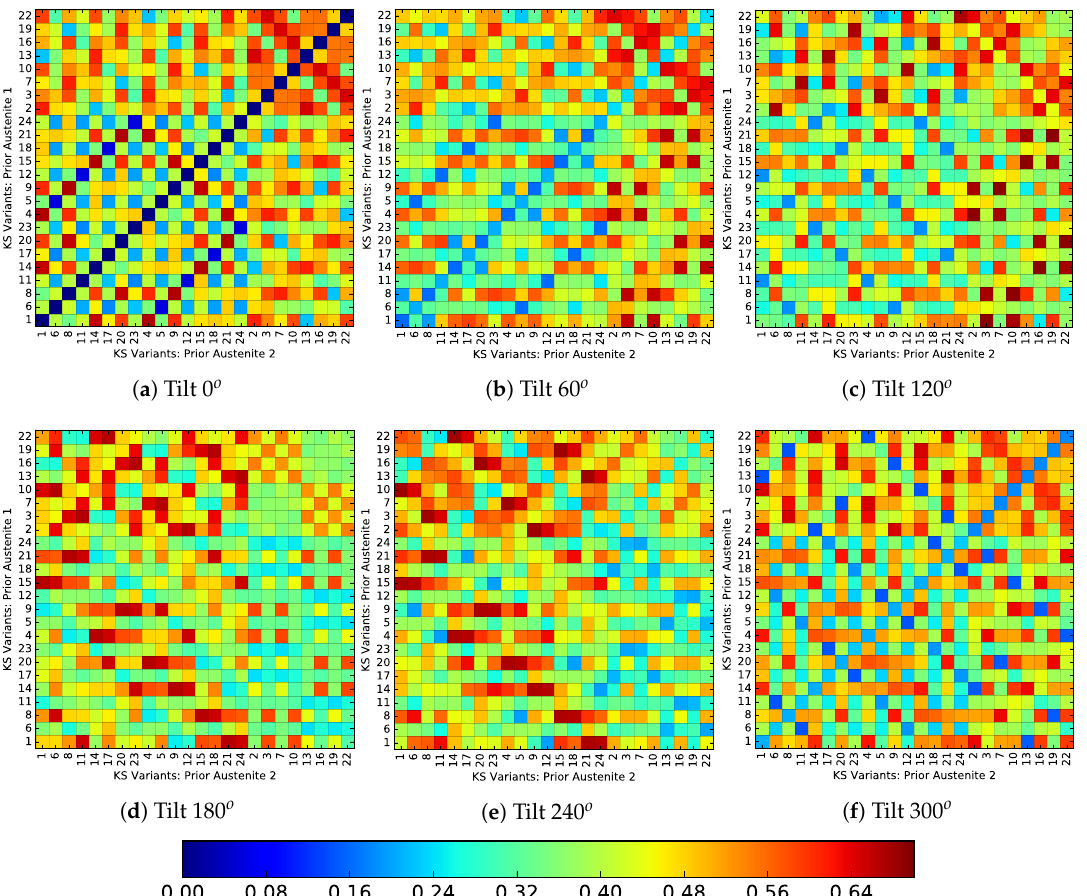
Figure 14. Transformation strain incompatibility for PAGBs with tilt misorientation. The variant groups are ordered according to the Bain groups and in the order C first, then the variants of B and A (last), Table A2.